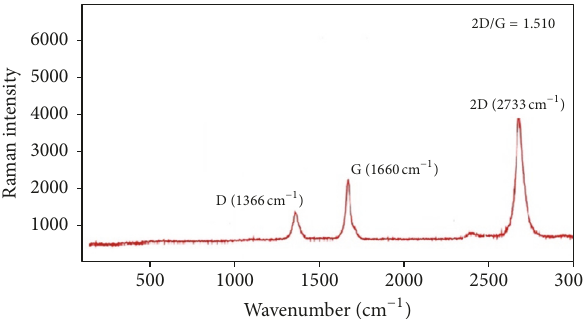
Figure 7: Raman spectrum of the electroreduced GO produced by Hammers